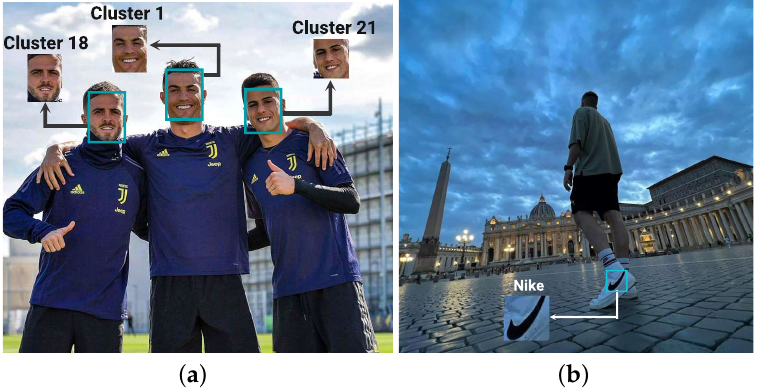
Figure 4. The result of the models in the object detection module. ( a ) face detection, ( b ) logo